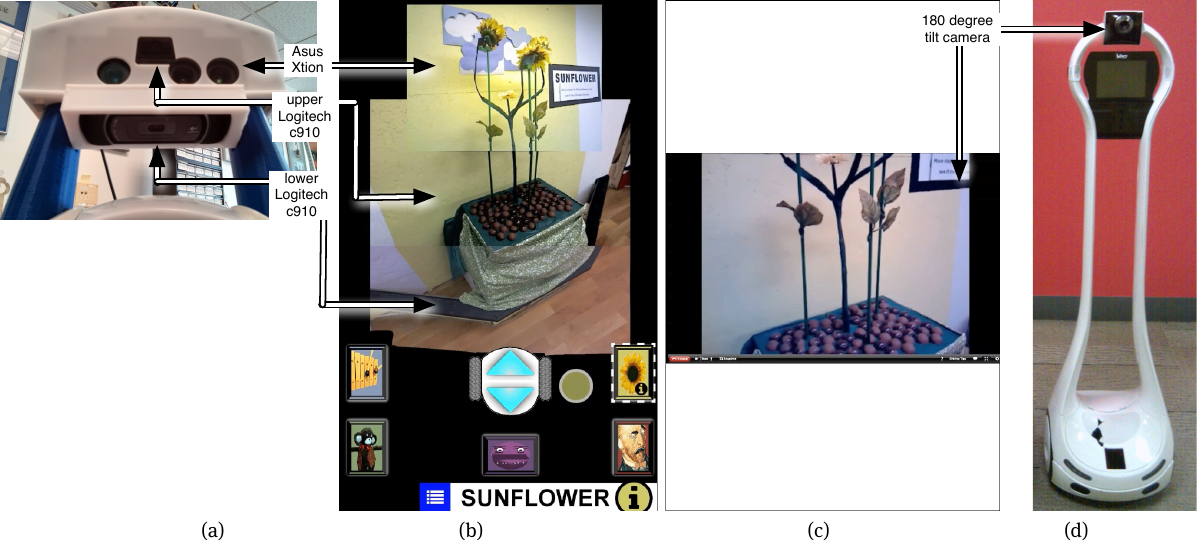
Fig. 4. (a) Margo’s three cameras in the hat are stitched together in a single vertical panoramic video stream; our cameras and correspond- ing portion of the view are shown. (b–c ) The robot is located at the left hotspot of the Sunflower exhibit. Our interface is shown on the left, and the VGo App on the right. (d) The standard VGo robot’s 180 ∘ tilt